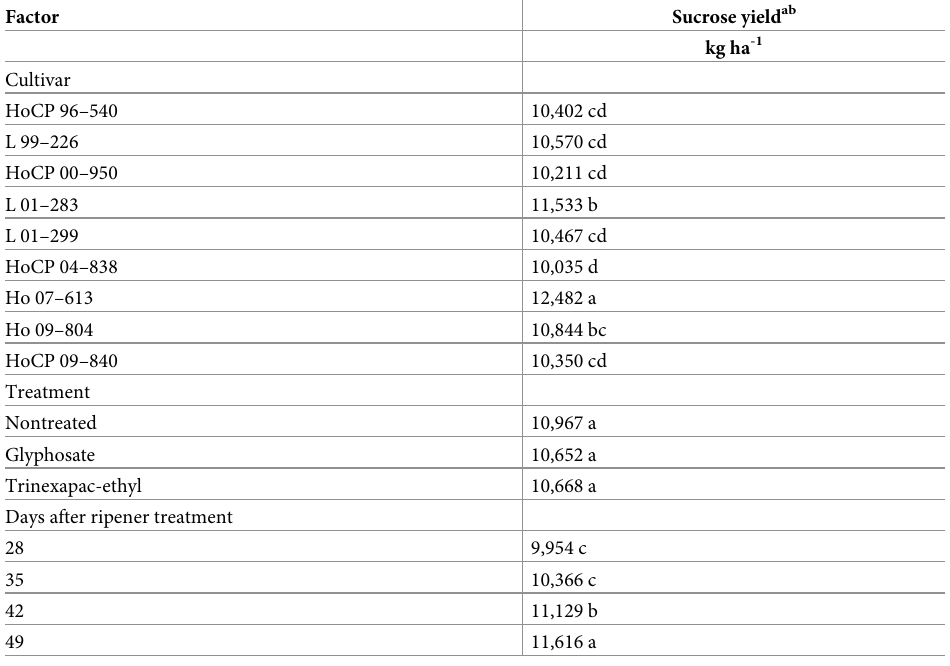
11,616 a a Data were square root transformed and means were back transformed for presentation. b Means within cultivar, treatment, and days after ripener treatment that are followed by the same lower case letter are not significantly different according to Tukey HSD